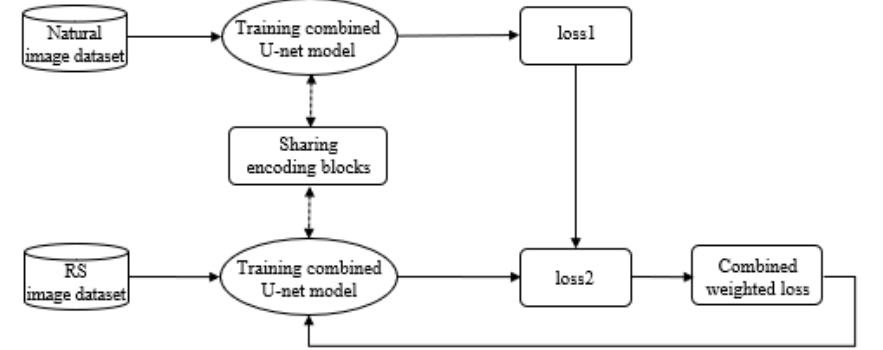
Figure 2. Framework of the proposed method. The combined U-net model shares encoding blocks and is trained using the combined weighted loss.